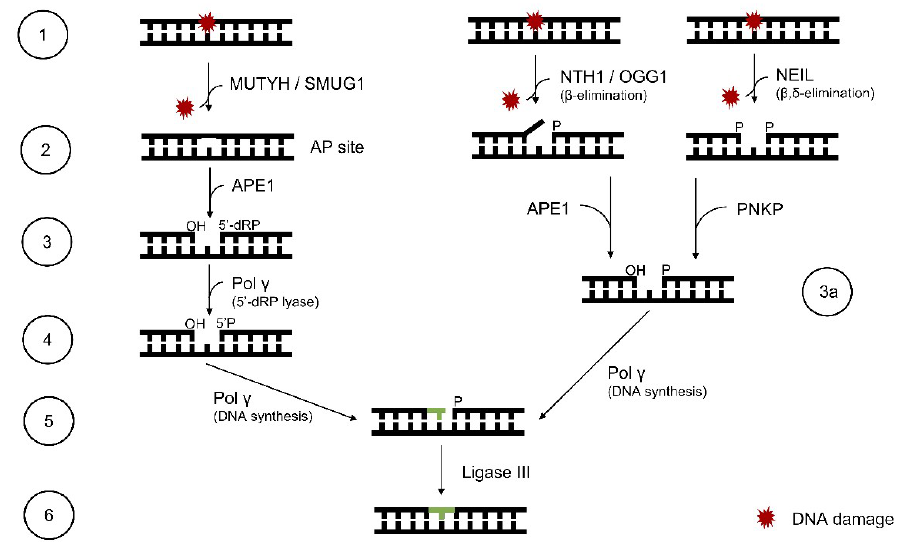
Figure 3. The base excision repair (BER) system in mitochondria. (1) The first step is the action of DNA glycosylases. Depending on the type of damage, different glycosylases are recruited: monofunctional—molecule and adenine DNA glycosylase (MUTYH), single-strand selective monofunctional uracil DNA glycosylase (SMUG1), or bifunctional— endonuclease III homolog 1 (NTH1), 8-oxo-G DNA glycosylase 1 (OGG1), Nei-like 1 (NEIL). DNA glycosylase cleaves the β-N-